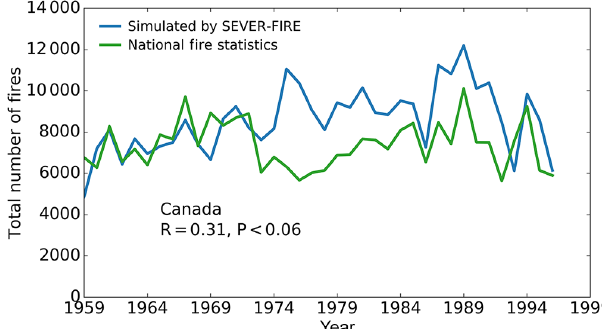
Figure 3. Registered and simulated number of fires in